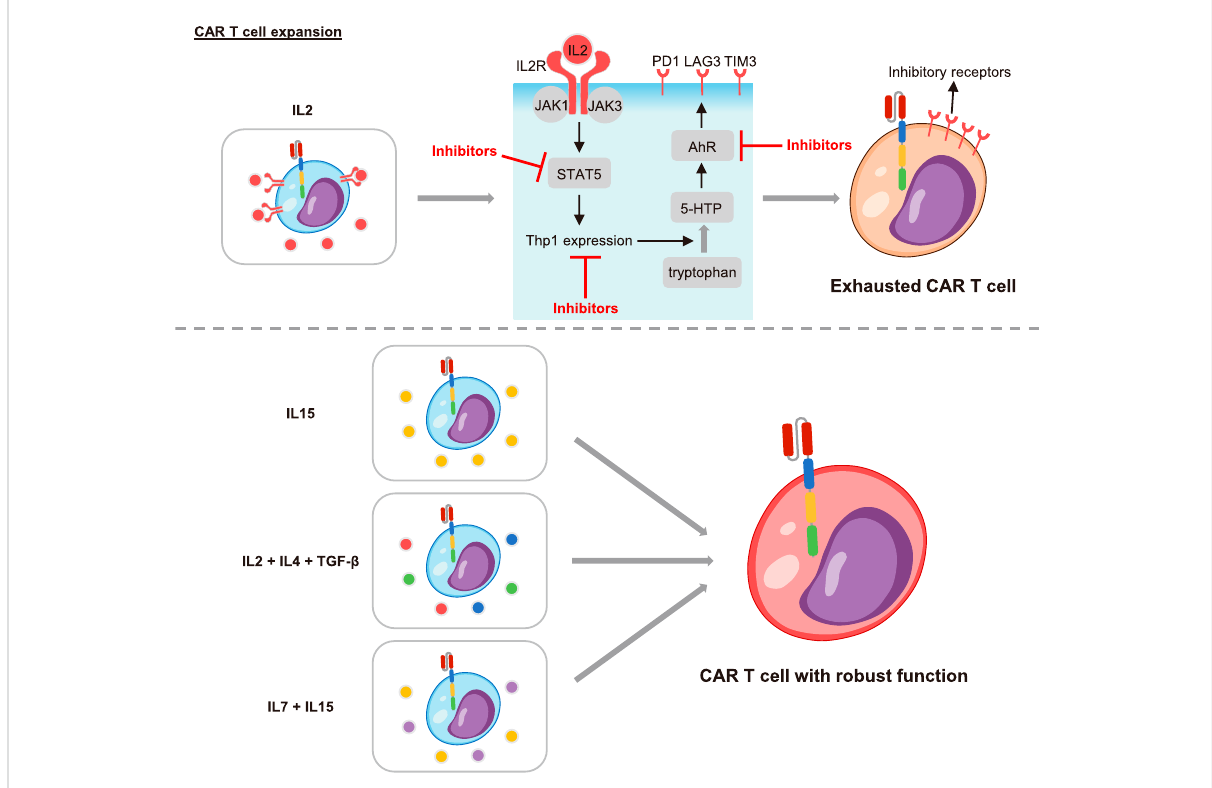
FIGURE 2 The effects of cytokines on CAR T cell exhaustion. The cytokine IL2 promoted CAR T cell exhaustion through the IL2 receptor (IL2R). The combinationof IL2 and IL2R led to therecruitment and activation of theJanus family oftyrosine kinases(JAK1 and JAK3). Then thesignal transducer and activator of transcription 5 (STAT5) was activated and further induced the expression of tryptophan hydroxylase 1 (Tph1). The Thp1 catalyzed tryptophan to produce 5-hydroxytryptophan (5-HTP), which activated the aryl hydrocarbon receptor (AhR) and led to T cell exhaustion. Inhibitors of STAT5, Thp1 or AhR could all restrain T cell exhaustion. Importantly, the cytokine IL15, IL2 supplemented with IL4/TGF- β , and IL15/IL7 improved the exhaustion. CAR T cells under these culture conditions manifested enhanced persistence and